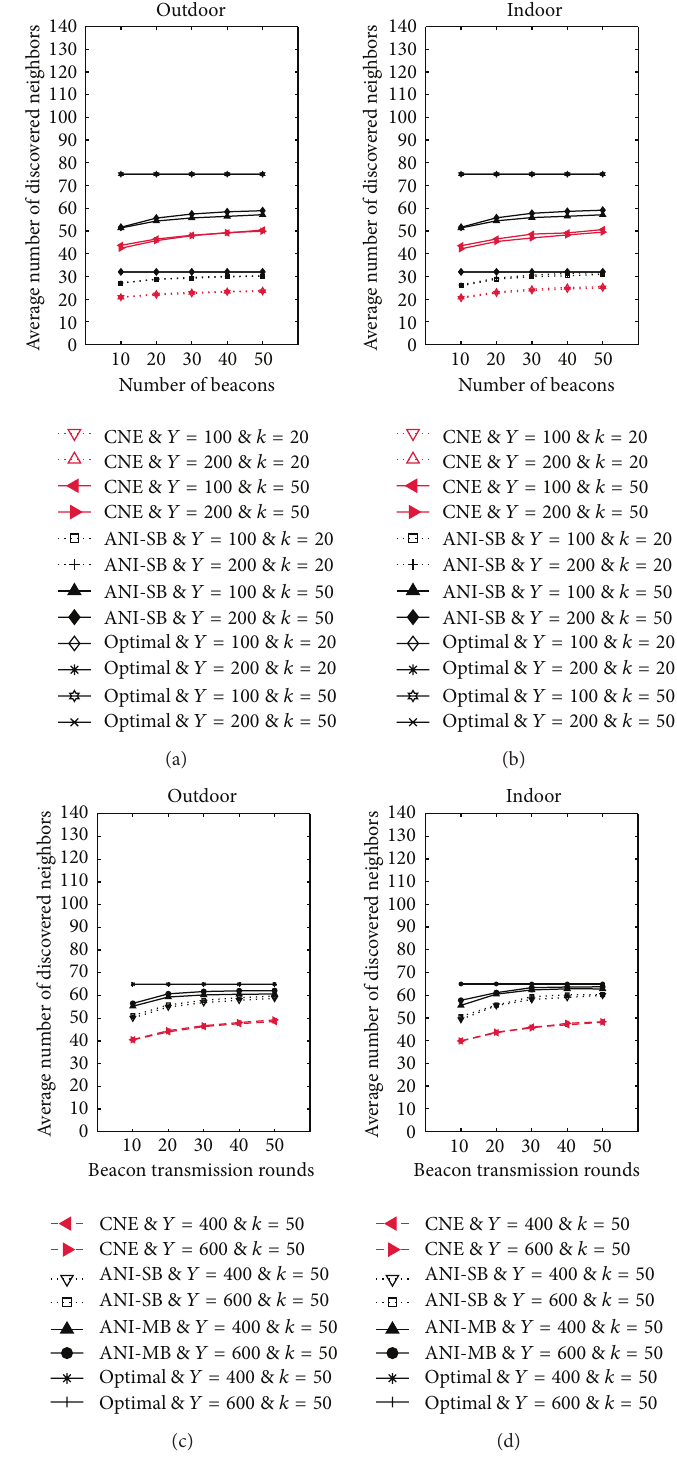
Figure 6: Average number of discovered neighbors by ANI-SB, ANI-MB, and CNE protocols in multihop topology networks deployed in outdoor and indoor